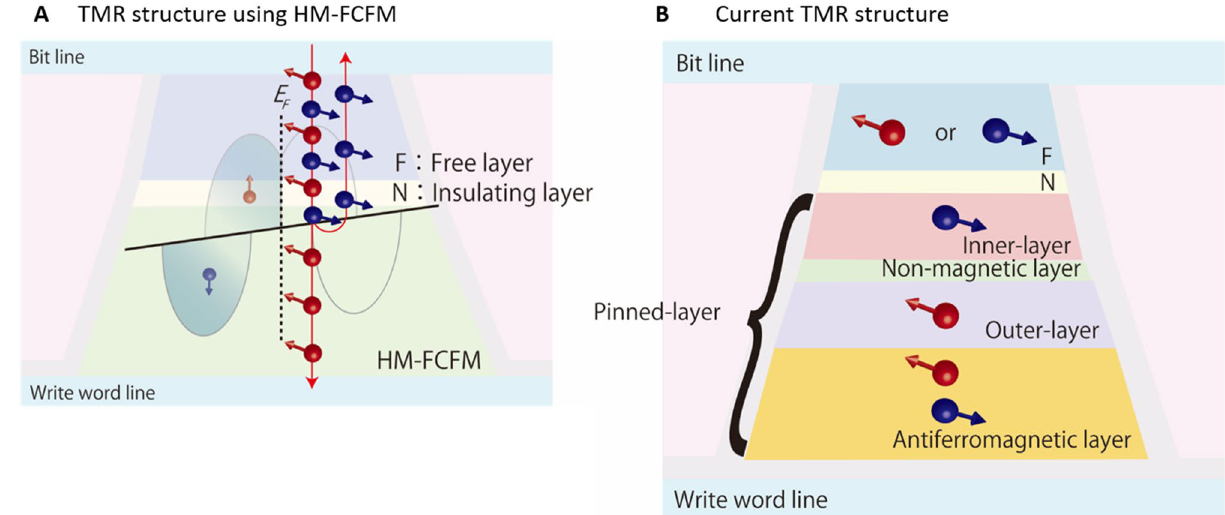
Figure 5. Illustration of a TMR device. ( A ) Schematic of a potential TMR device with a ferromagnetic free layer (F), non-magnetic (insulator) layer (N), and pinned layer of half-metallic fully compensated ferrimagnet (HM-FCFM). The HM-FCFM layer acts as an electron conductor in one spin orientation (up-spin, shown in red) but as an insulator in the opposite orientation (down-spin, shown in blue), as depicted in the schematic DOS for antiferromagnetic coupling. ( B ) Conventional TMR structure with a pinned layer, comprising an inner layer, a non-magnetic layer (e.g., Ru-layer), an outer layer, and an antiferromagnetic layer. The device in ( A ), in which the HM-FCFM layer replaces the pinned layer in ( B ), facilitates a higher TMR ratio and lower leakage current than the device in ( B